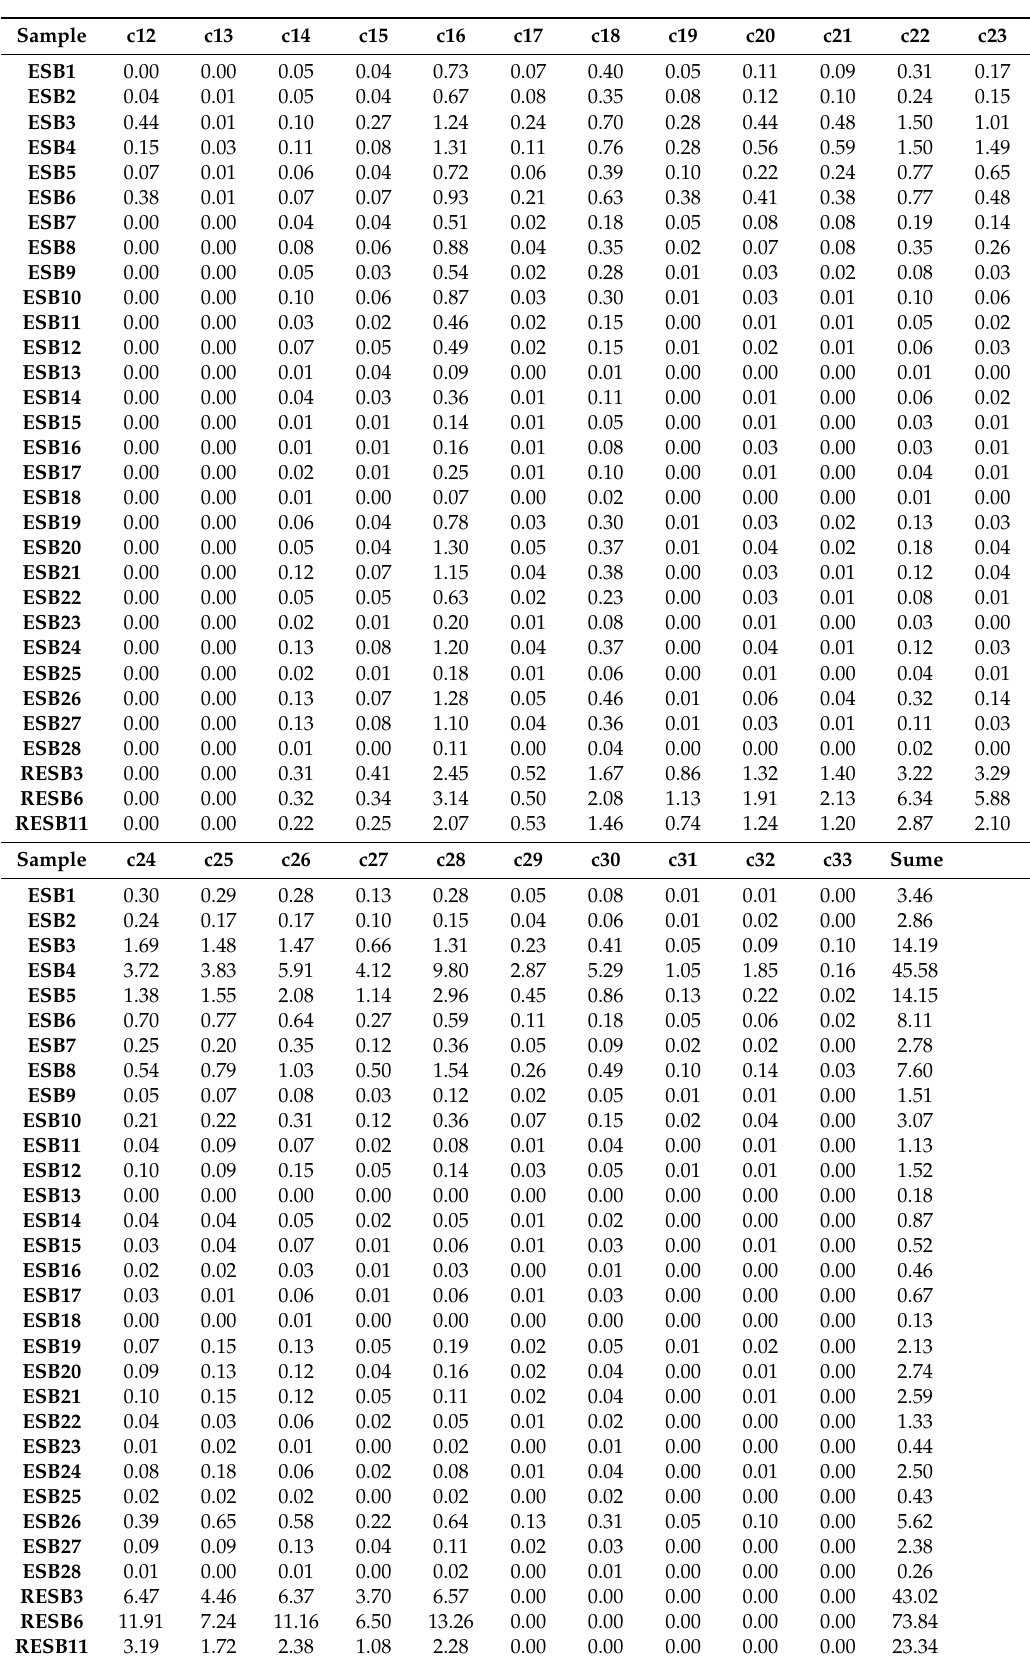
Table 7. n -alkanoic acids content ( µ g/g) of the samples